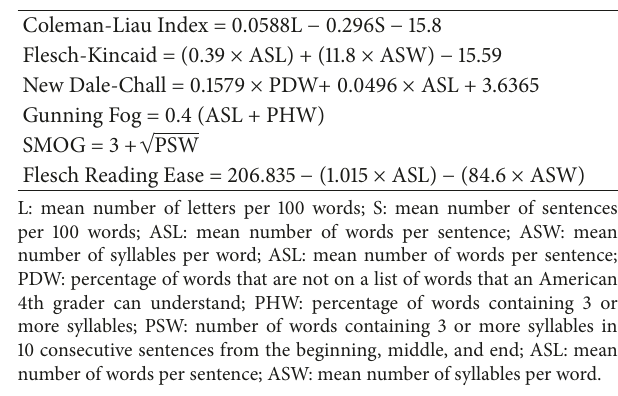
Table 1: List of formulae used by different readability grade estimation models for textual